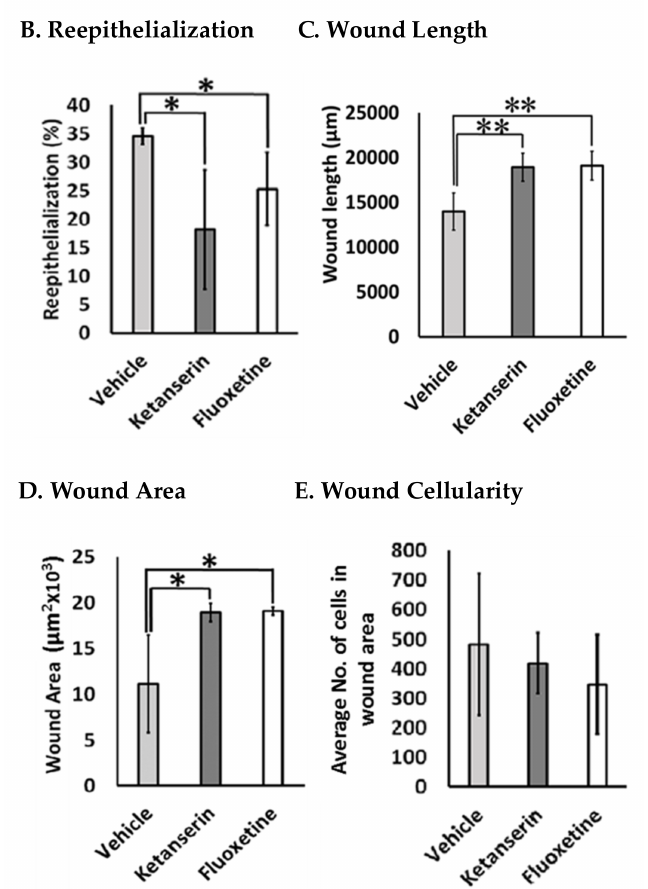
Figure 3. Comparative post thermal skin wound healing in vehicle, ketanserin, and fluoxetine treated groups. ( A ) Masson’s trichrome staining of two weeks’ post burned skin wound cross-sections (image center). Burn wound area characterized with reddish scab (present over wound), distinguishes it from normal skin. Epidermis stained in red and dermal collagen fibers are stained in blue. Reepithelialization: wound images show new epidermal edge (marked with black arrows), formed over left and right wound margins (dotted black line), and progressing towards the wound center (dotted black arrow head line). Image scale: 50 µ m. New epidermal layer zoomed at right margins (white arrows mark the newly formed thick layer of epidermis and transparent arrow indicate poorly formed epidermis) (image left). Wound dermal area characterized with granulation tissue. Images show wound cellularity at wound dermal region (dotted black box showed selected area from each image) (image right). Image scale: 100 µ m. ( B ) Graphical results show comparative reepithelialization (%), ( C ) wound length ( µ m) ( D ) wound area ( µ m 2 × 10 3 ) and ( E ) wound cellularity (average number of cells in wound healing zone) among treatments after two weeks’ post thermal injury. Results were presented as mean ± Standard Deviation (SD), (* p < 0.05, ** p < 0.01), n =